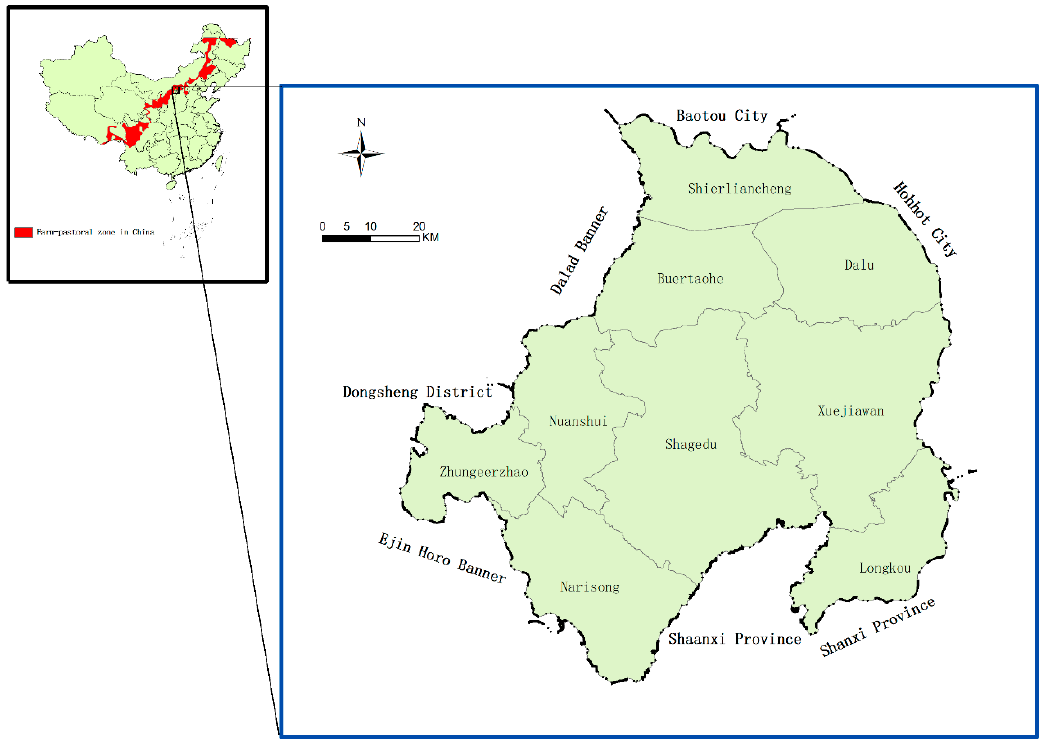
Figure 1. The location of Jungar Figure 1 . The location of Jungar Banner.